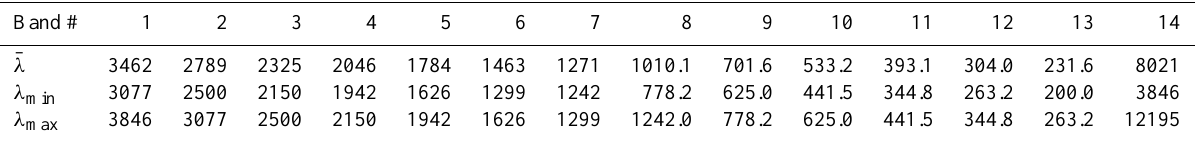
Table 1. Spectral bands distribution in RRTMG. From top to bottom rows, λ ’s (in nm) are band mean, band minimum and band maximum values, respectively. Note the band numbering does not follow increasing or decreasing wavelength values. The band naming convention follows the RRTMG